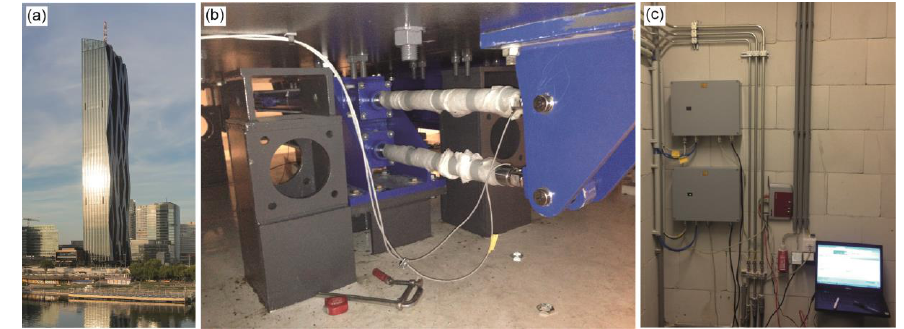
Figure 18. ( a ) Danube City Tower in Vienna, Austria; ( b ) MR-SVA of Danube City Tower with two controlled MR dampers and ( c ) two independent real-time controllers.